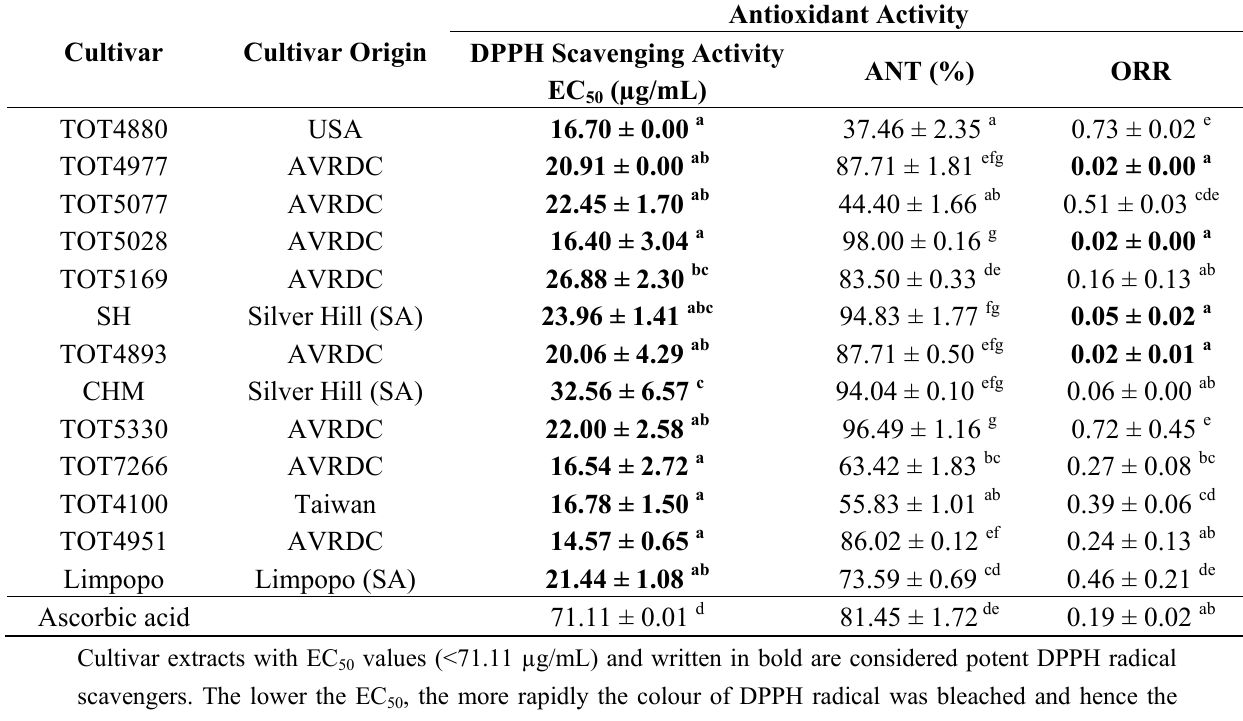
Table 1. Antioxidant activity of extracts from thirteen Moringa oleifera cultivars introduced from different geographical world locations as determined by the